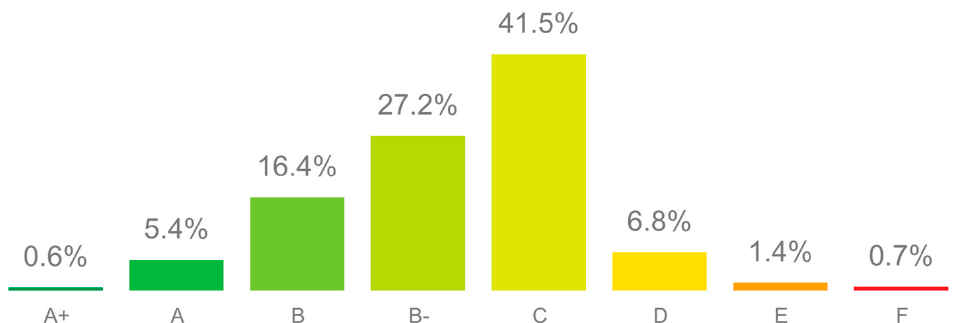
Figure 11. Energy class (from A to F) of the commercial and services building stock in 2020 in Portugal. © ADENE statistics.